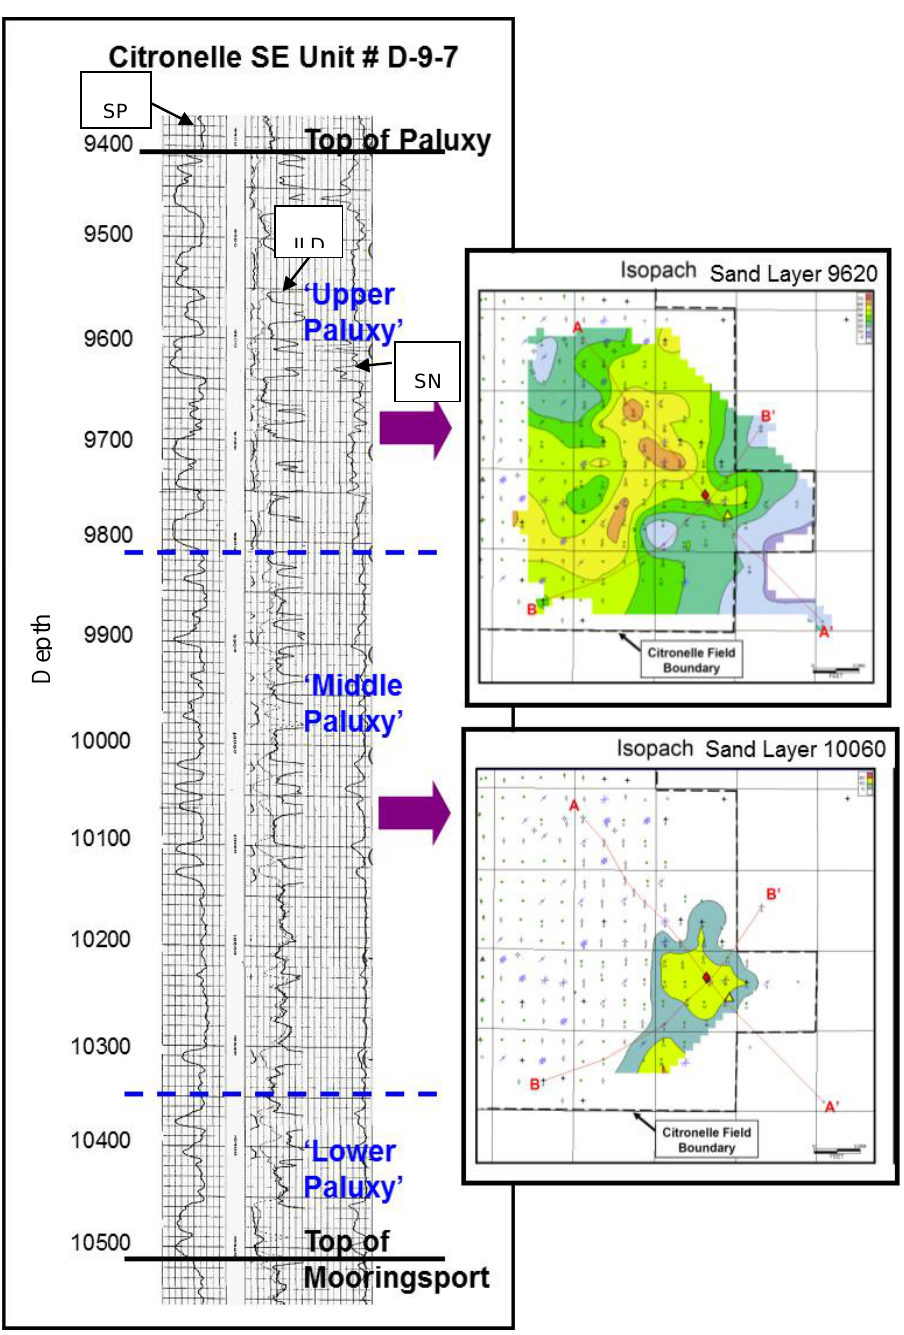
Figure 3. Vintage well log (left) showing the Paluxy Formation interval. The left track is spontaneous potential (SP) and the track to the right shows the induction (ILD) and short normal (SN) electrical logs. Paluxy sand maps (right) constructed from the vintage well logs. Source: Author Conception. (Right) Isopach map generated using Petra ® .